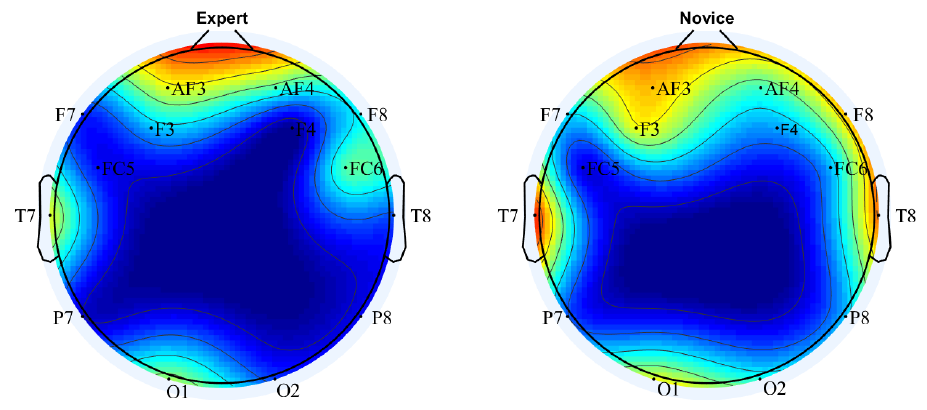
Figure 7. Brain visualization for baseline activity using the average power spectral density for an expert and novice